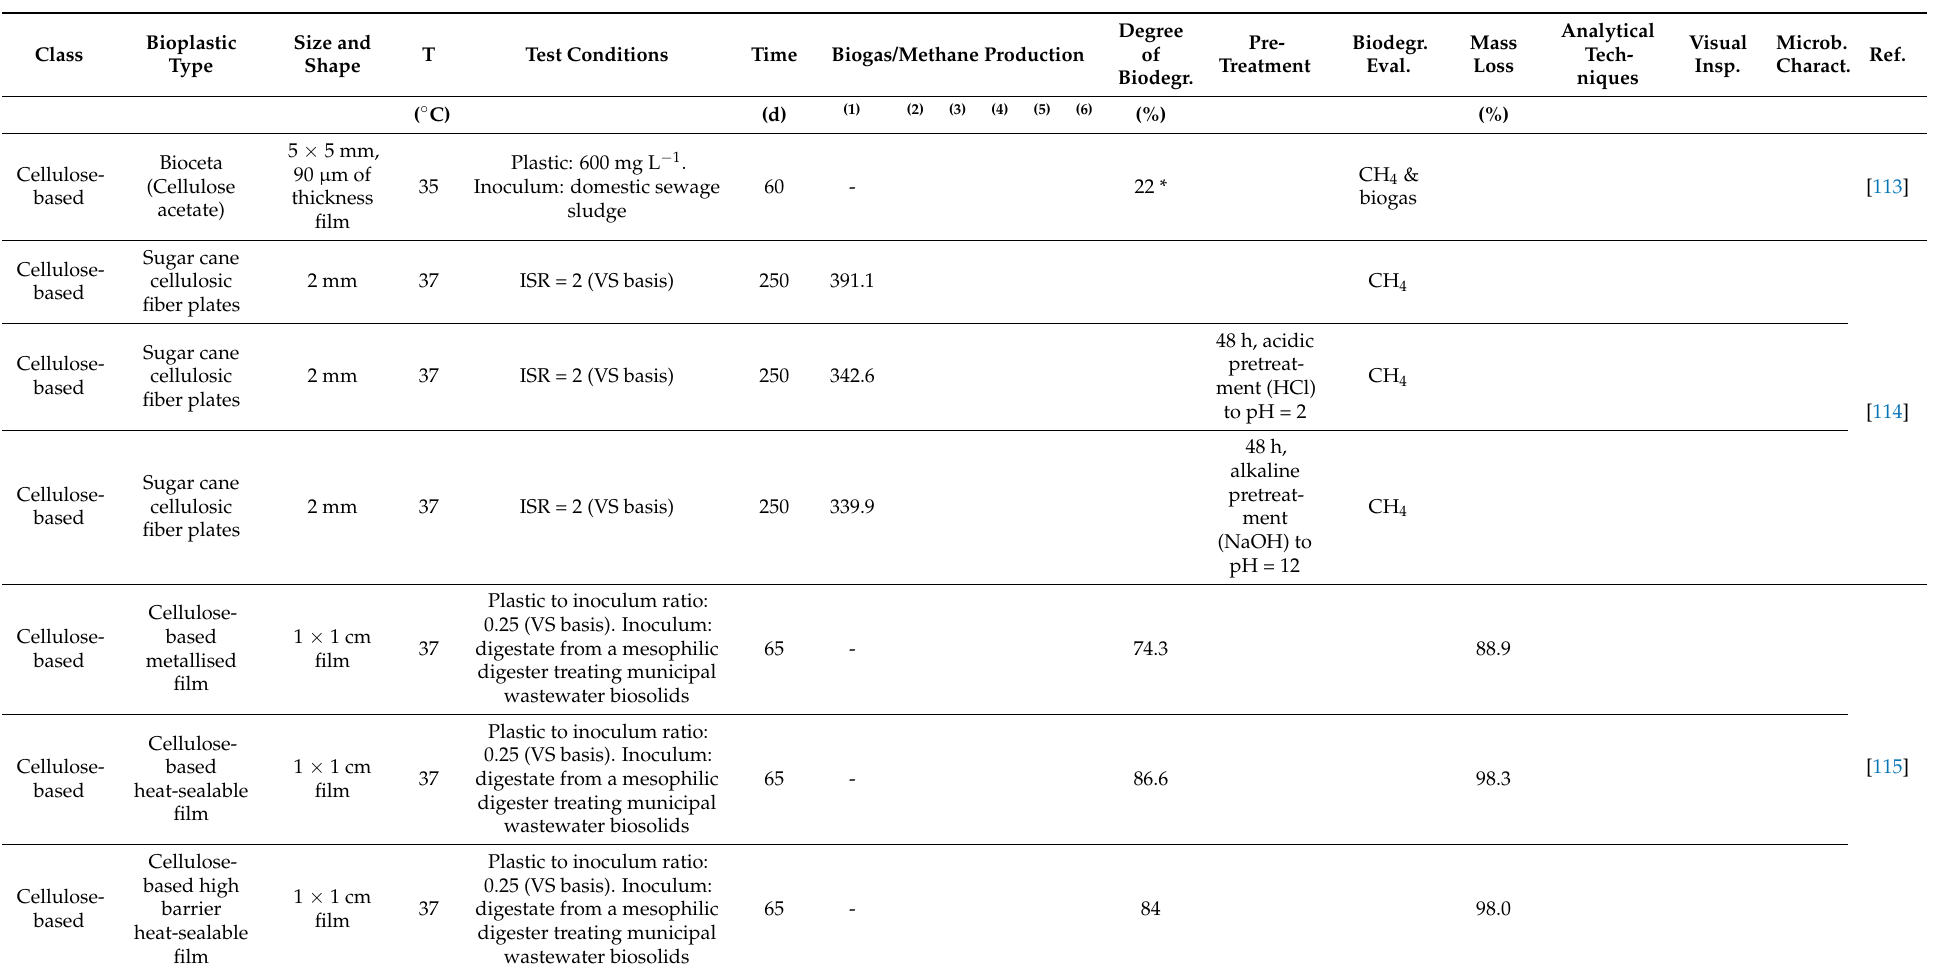
Table A1. Summary of literature results related to anaerobic degradation of different bioplastic products under mesophilic conditions (expanded from